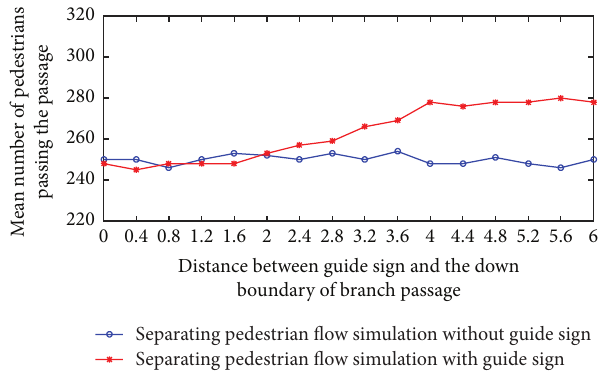
Separating pedestrian flow simulation without guide sign Separating pedestrian flow simulation with guide Figure 10: The mean number of pedestrians passing the passage with different position of guide